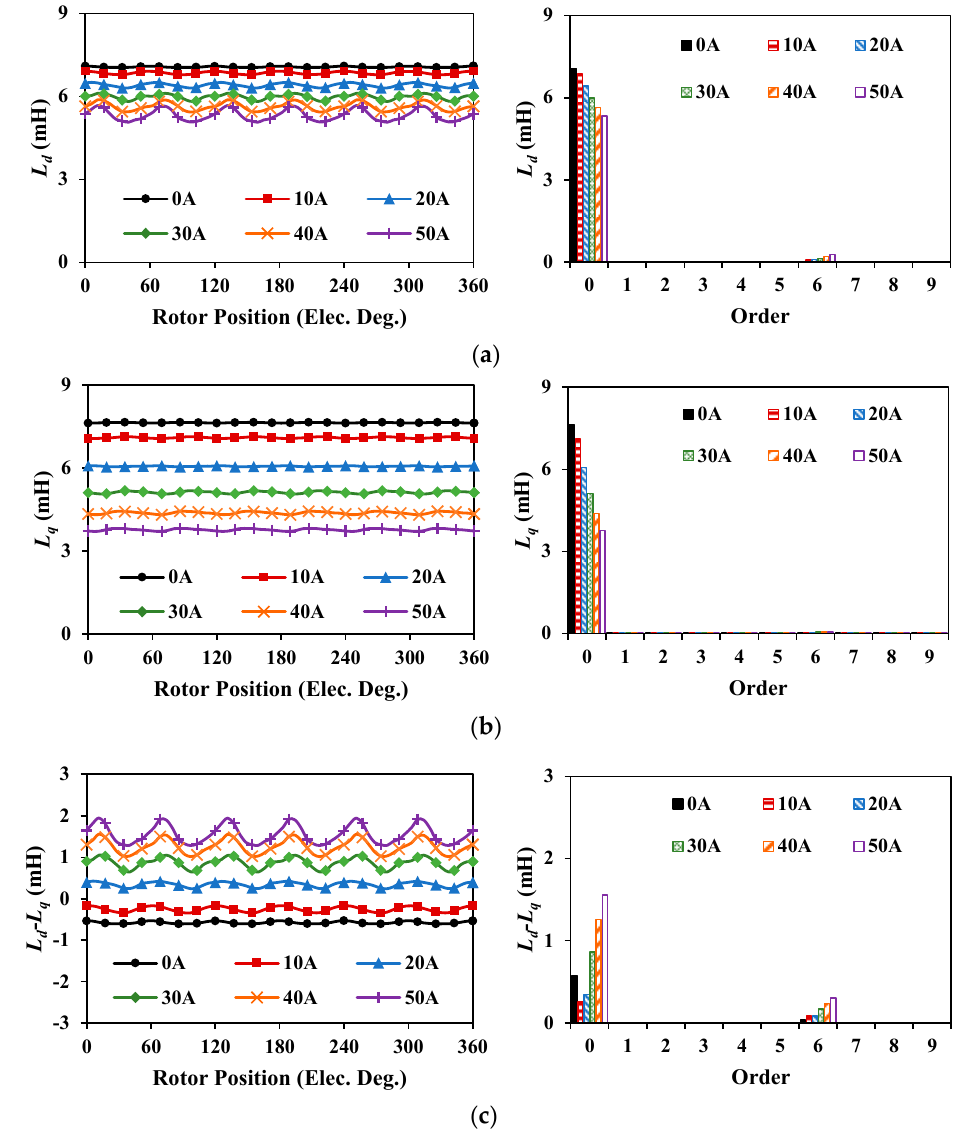
Figure 19. Inductances and spectra for 12s10p CCPPM machine. ( a ) L d . ( b ) L q . ( c ) L d - L q .